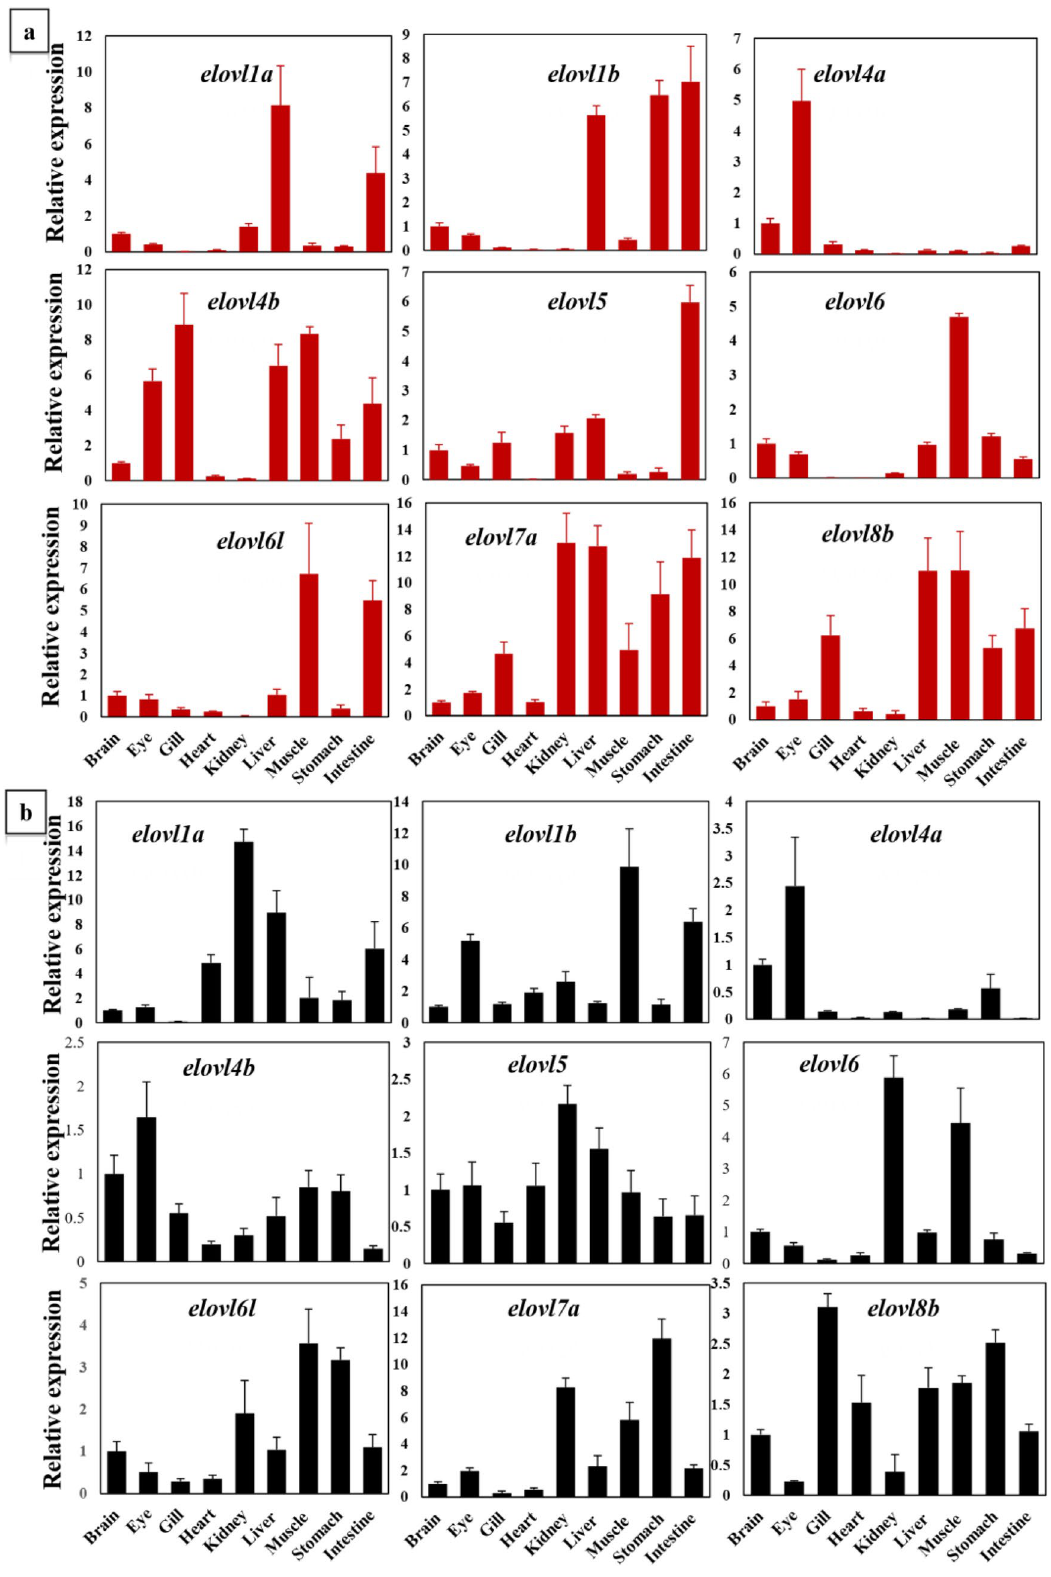
Figure 7. qPCR assessment of tissue distribution of elovl1a, elovl1b, elovl4a, elovl4b, elovl5, elovl6, elovl6l, elovl7a , and elovl8b gene expression in ( a ) E. tetradactylum and ( b ) E. rhadinum for various tissues including the brain, eye, gill, heart, kidney, liver, muscle, stomach, and